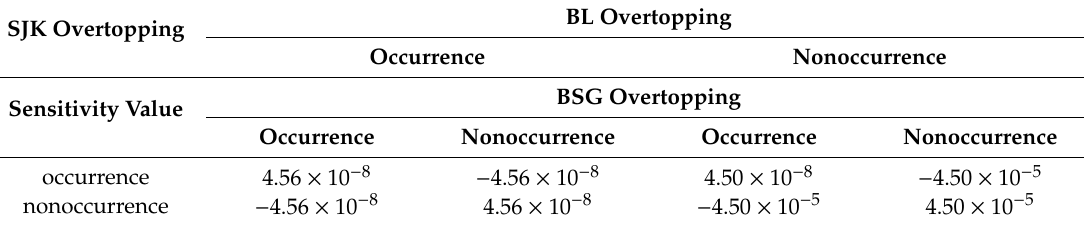
Table 8. The sensitivity analysis of SJK Overtopping, according to the BSG Overtopping node.